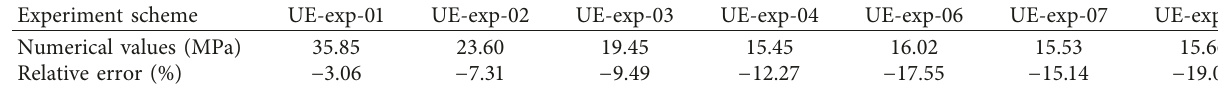
Table 10: Shock wave peak pressures under different working conditions.